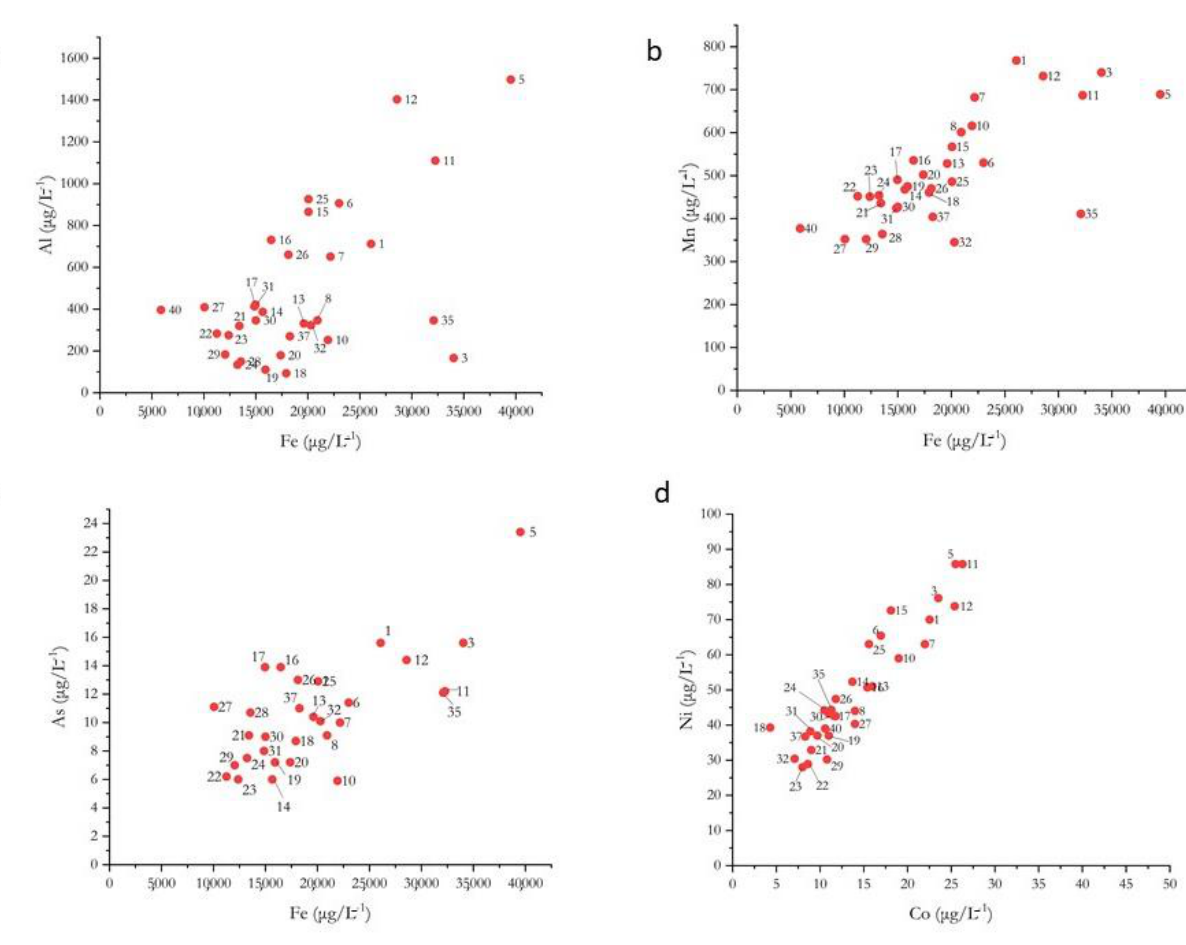
Figure 5. Binary diagram of Fe vs. Al ( a ), Mn ( b ) and As ( c ) and Ni vs. Co. All values are in mg L − 1 . The numbers refer to the different sampling surveys (see Table 2). Statistical data for: ( a ) r = 0.5791, p = 0.0005; ( b ) r = 0.7328, p = 0.00001; ( c ) r = 0.7076, p = 0.00001; ( d ) r = 0.9326, p = 0.0001.